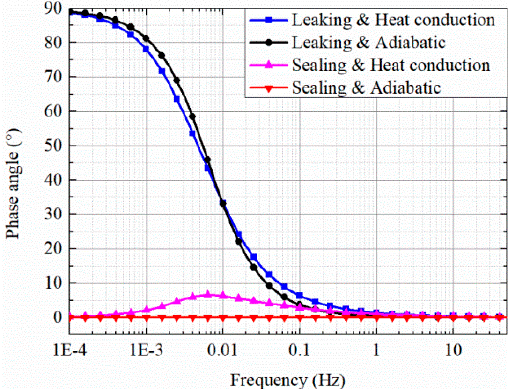
Figure 5. Phase difference between the calibrating sound pressure and the piston displacement. Figure 5. Phase di ff erence between the calibrating sound pressure and the piston